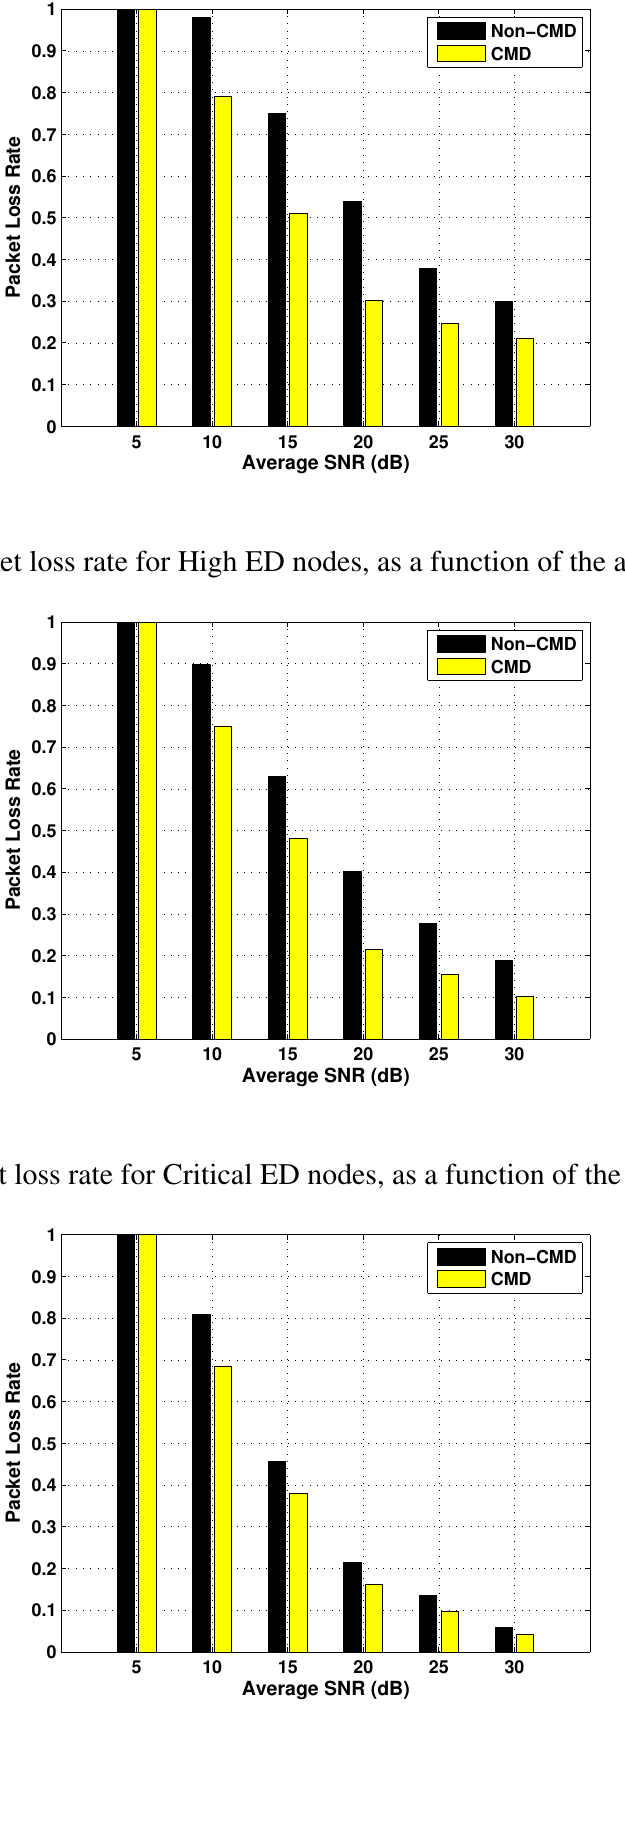
Figure 5. Packet loss rate for Low ED nodes, as a function of the average SNR.